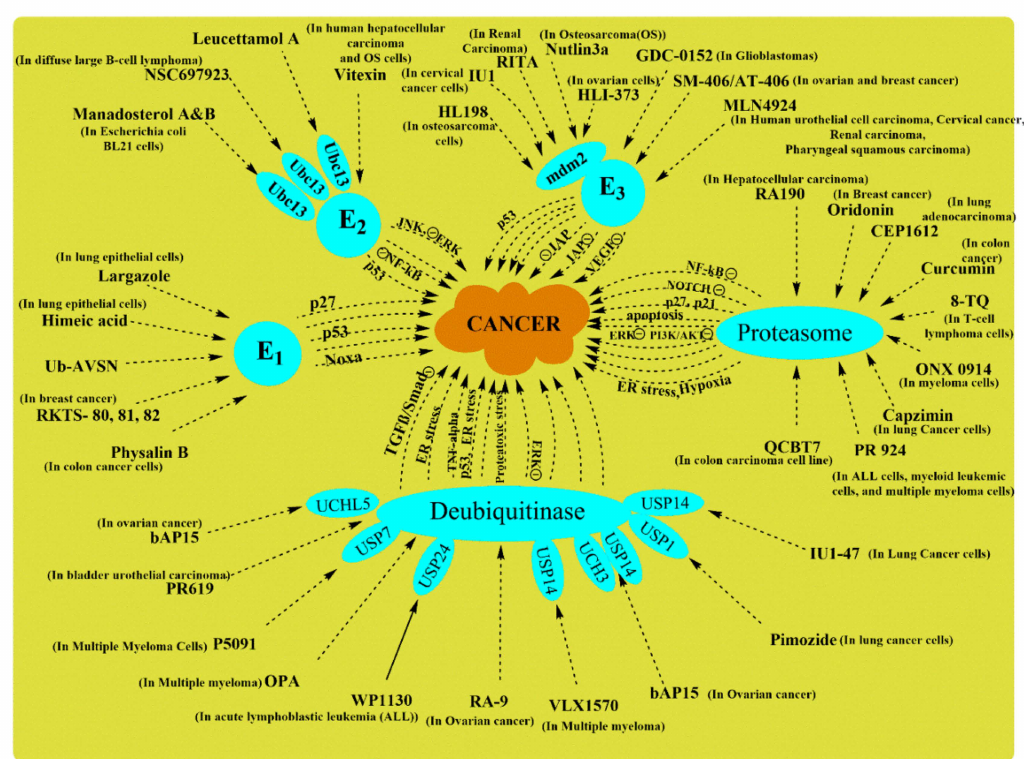
Figure 6. This figure depicts the complex interconnection between various enzymes and the pathway enzymes follow. The enzymes modulate one or more oncogenic pathways through components actively functional in the